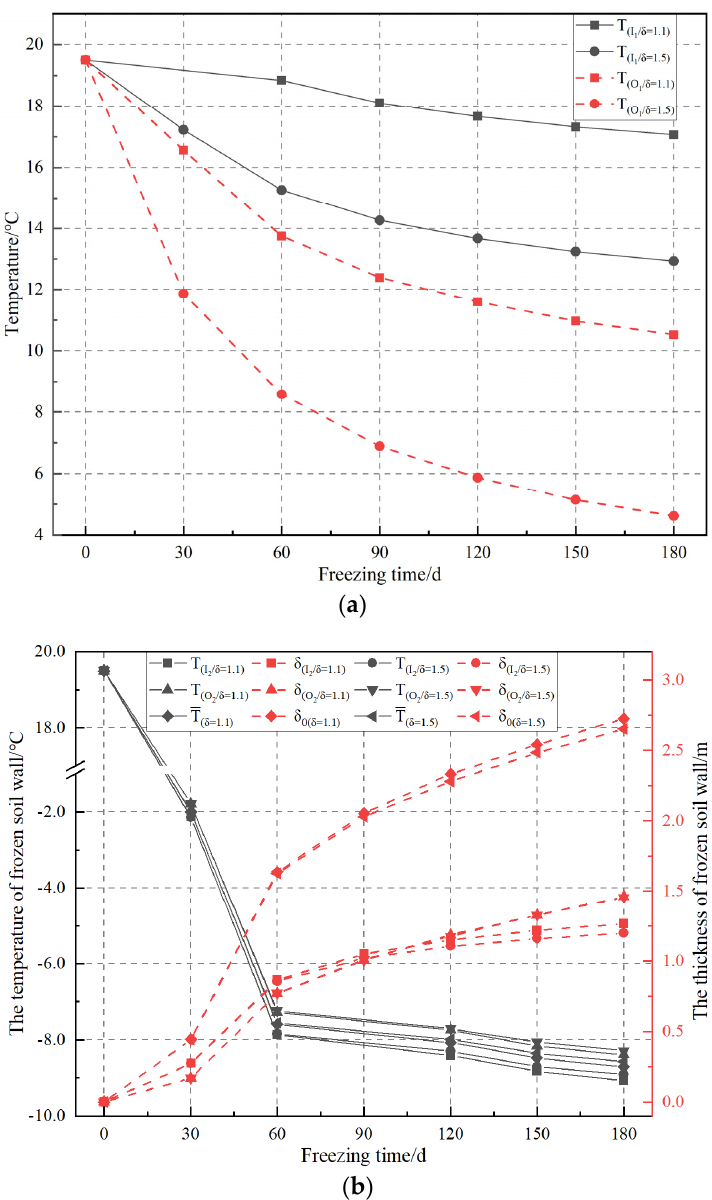
Figure 20. Variance in temperature and thickness under different shaft wall thicknesses and freezing time: ( a ) temperature in the interlayer and outside wall of the shaft, ( b ) temperature and thickness in the inside and outside of frozen soil wall and its average or sum value with shaft wall thicknesses of 1.1 m and 1.5 m.